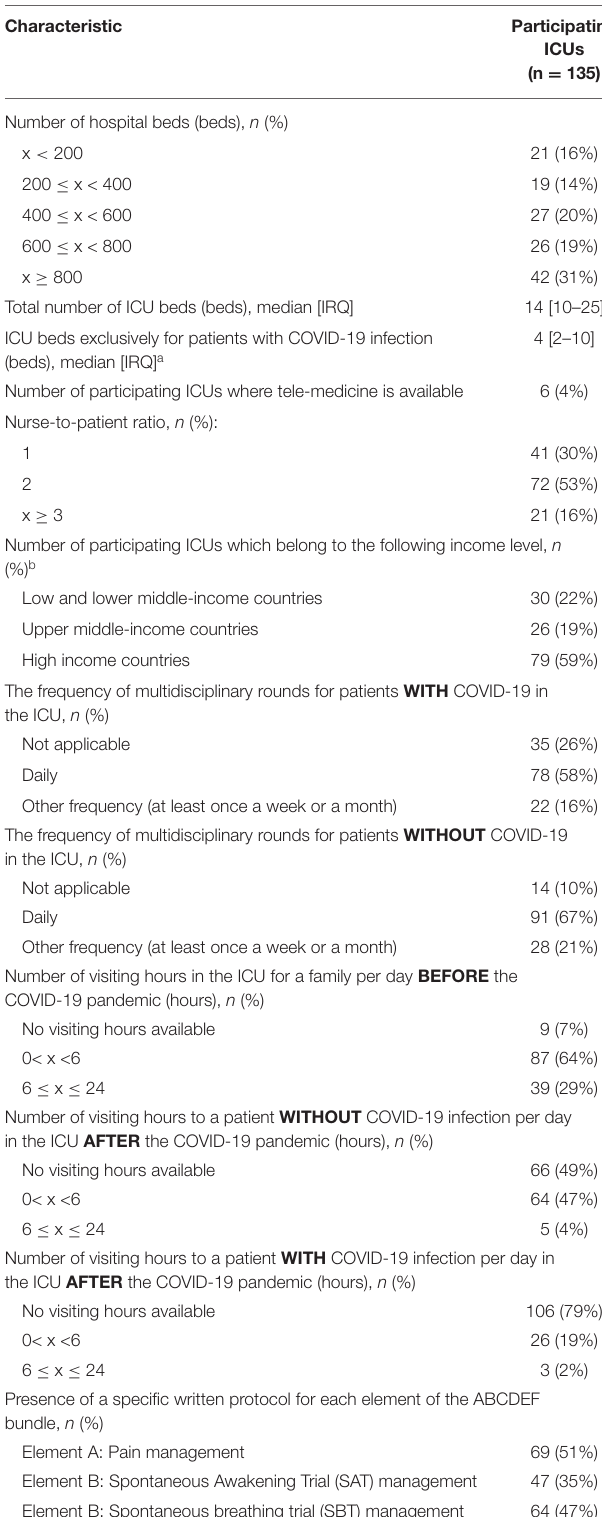
TABLE 2 | Background, administrative structure, and policies of participating hospitals and